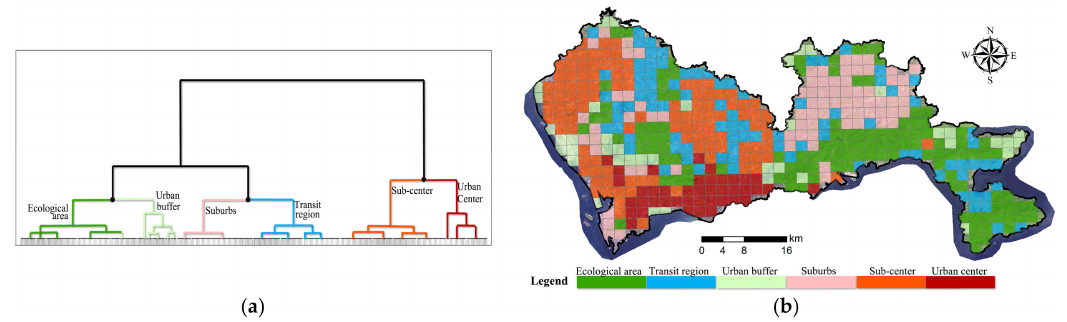
Figure 8. Urban functional zones. ( a ) The dendrogram. ( b ) Clustering result (with six clusters).